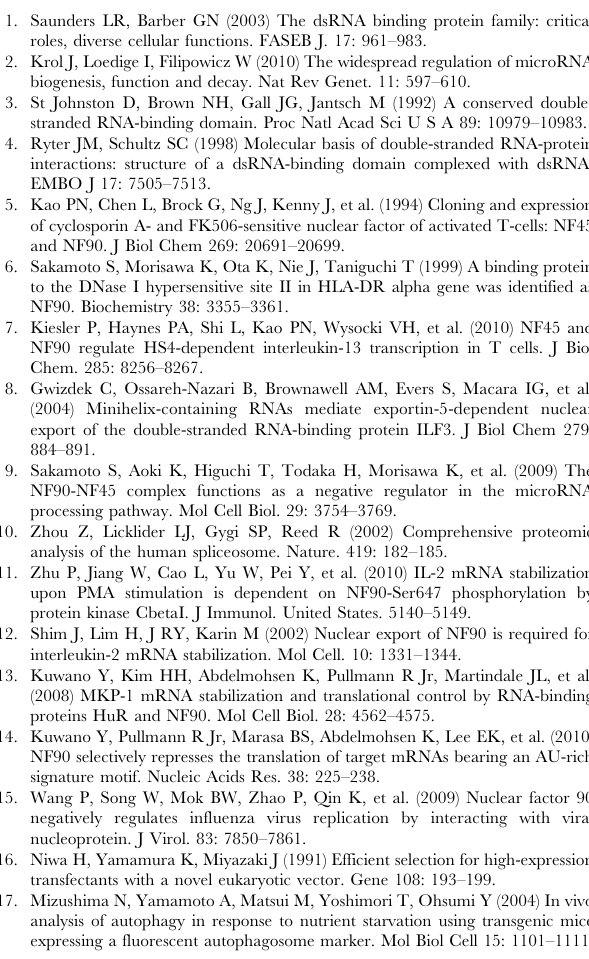
(lines TG1). Anti- a -tubulin was used as loading control. W-1 (TIFF) Table S1 A list of NF90-associated proteins. Molecular weights (MW), NCBI accession numbers (accession No.), cellular localizations and known functions in mammal of the proteins shown in figure 5A are indicated. The known functions in mammals were extracted from the NCBI database. (XLS) Table S2 A list of oligonucleotides used in this study. (DOCX) Methods S1 Detailed procedures and any associated references related to supplementary analyses are described in Methods